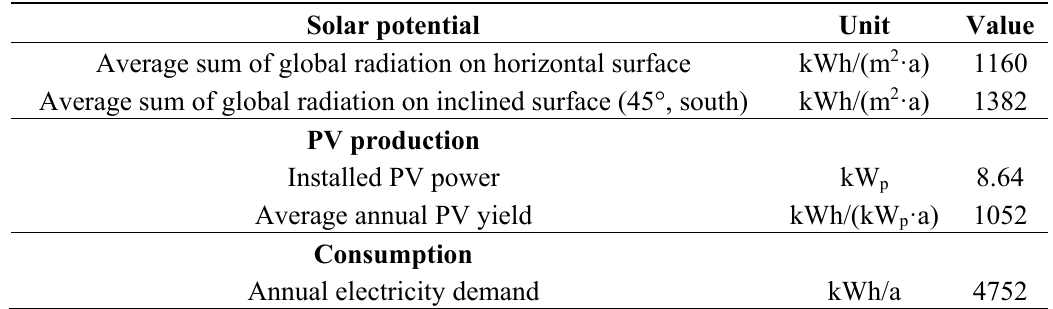
Table 1. Overview of input